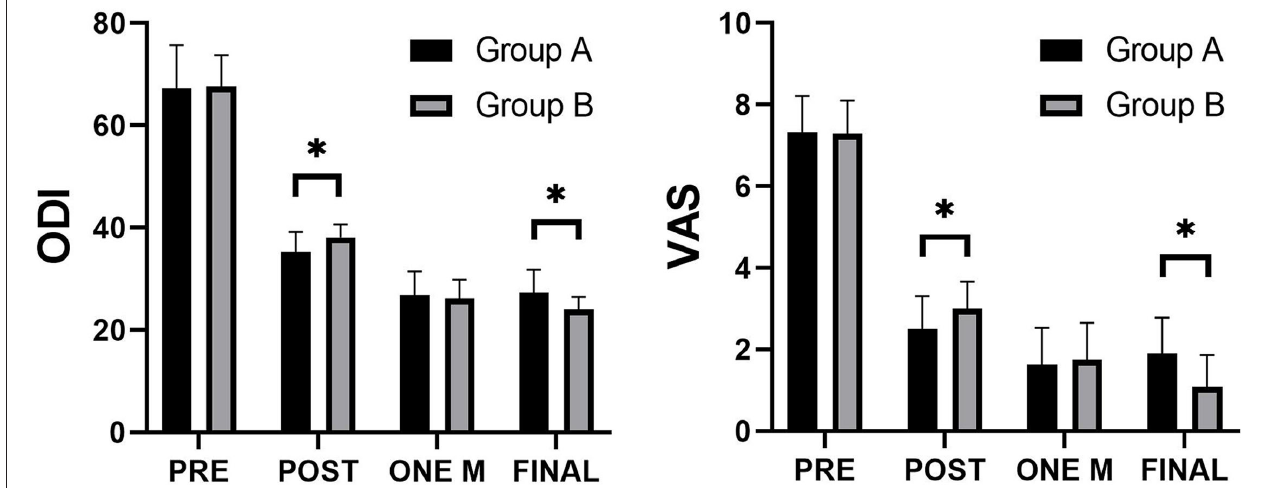
FIGURE 4 | Comparison of the Visual Analog Scale (VAS) and Oswestry disability index (ODI) scores between the two groups. * Significance between the two groups, P < 0.05.